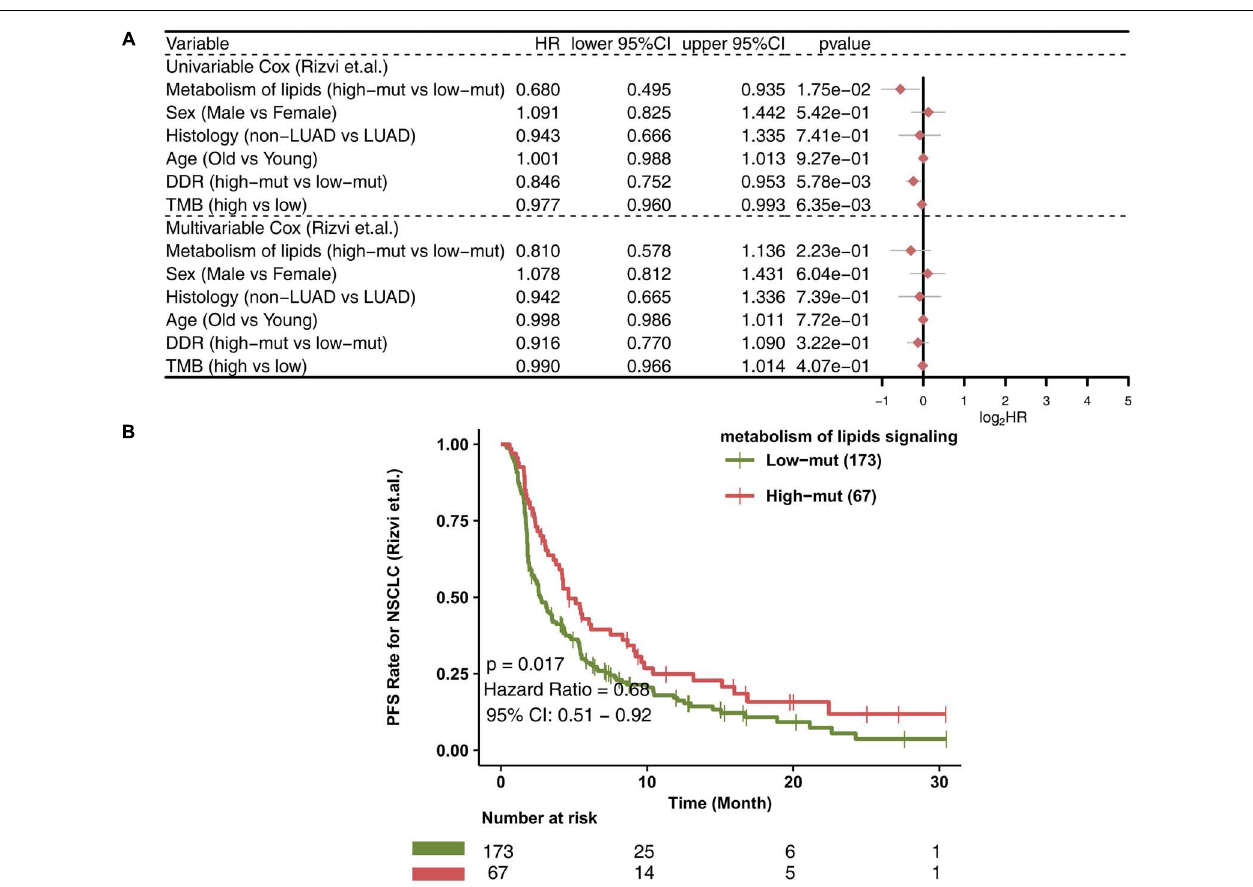
FIGURE 1 | The value of clinical characteristics and the number of mutations in the lipid metabolism pathway for predicting ICI efficacy. (A) Forest plot displaying the results of the univariate and multivariate Cox regression analyses in the ICI-treated cohort (Rizvi et al., 2018). The main portion of the forest plot presents the hazard ratio (HR) and 95% confidence interval (95% CI), and red dots indicate P < 0.05. Predictors of favorable outcomes have an HR < 1, and predictors of poor outcome have an HR > 1. (B) KM survival curves for PFS in 240 NSCLC patients from the ICI-treated cohort (Rizvi et al.,